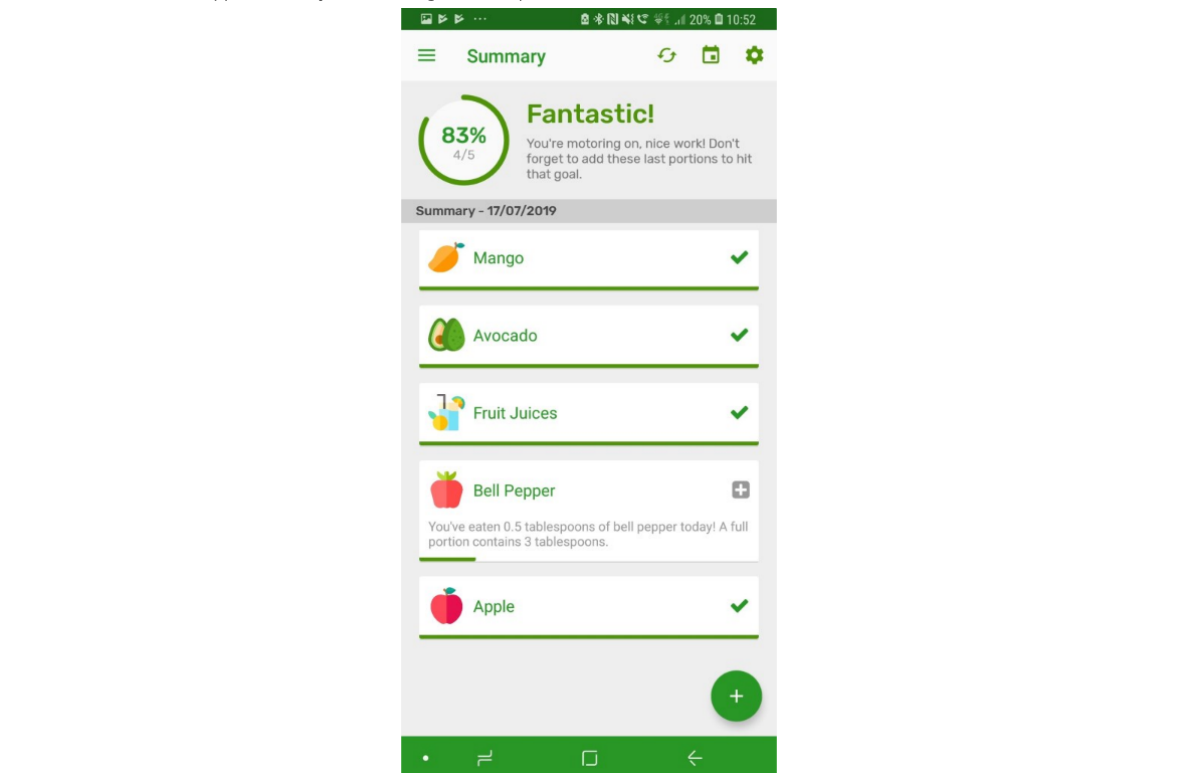
Figure 6. Screenshots of the app: Summary screen – high consumption.